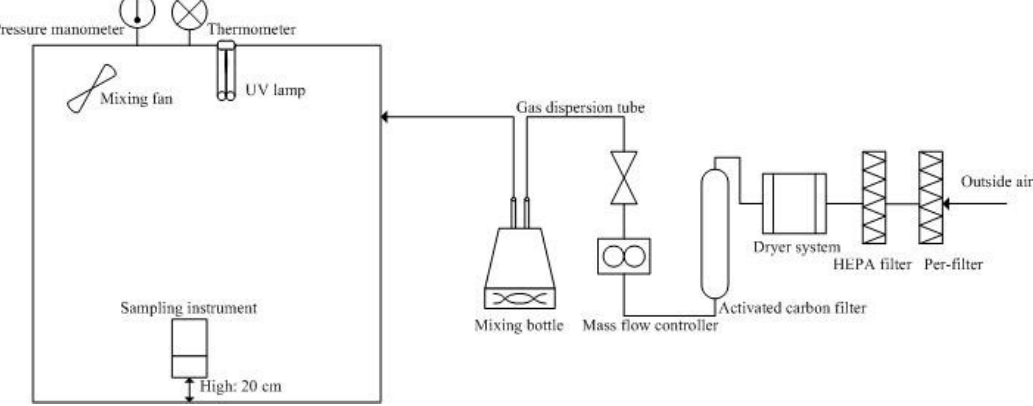
Figure 1. Schematic diagram of the UVGI experiment system.